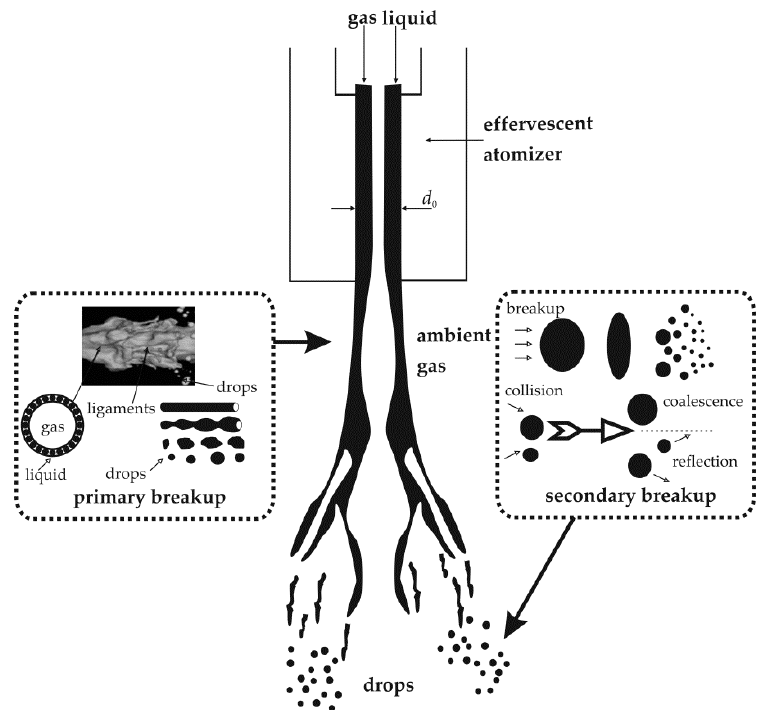
Figure 16. Schematic diagram of the atomization process with the use of an effervescent atomizer [7,72].